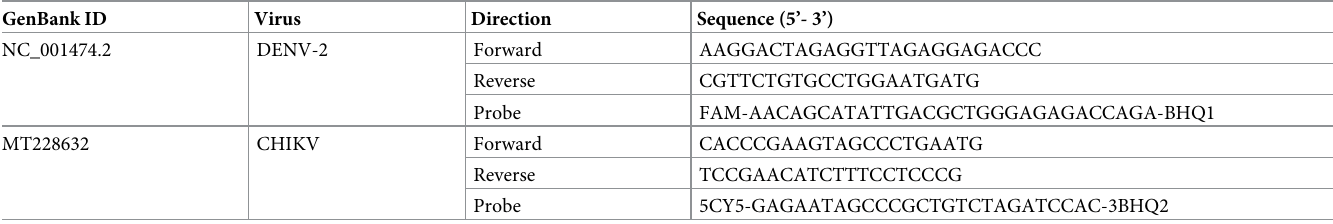
Table 1. Primers and probes for virus